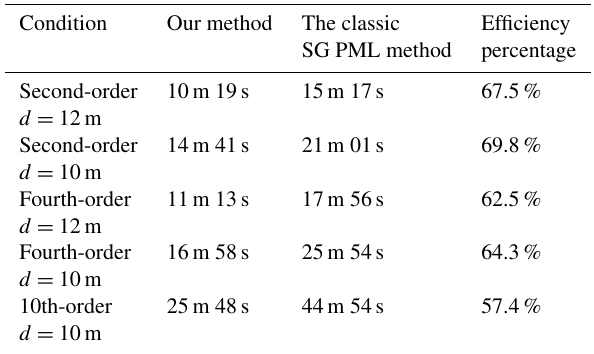
Table 1. Computation time for our and the classic SG PML meth-